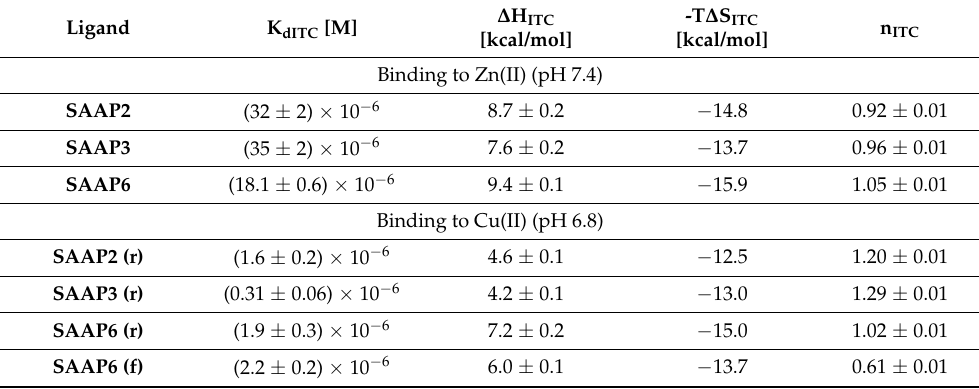
Figure 5. Representative ITC data (above) and their corresponding thermodynamic signatures (below) for Zn(II) (1.8–2.0 mM) titrated into ( A ) SAAP2, ( B ) SAAP3 and ( C ) SAAP6 peptides (140–180 µ M) at pH 7.4. Table 3. Experimental thermodynamic values for Zn(II) and Cu(II) binding to SAAP2, SAAP3, and SAAP6 from ITC measurements in 25 mM cacodylate buffer at 25 ◦